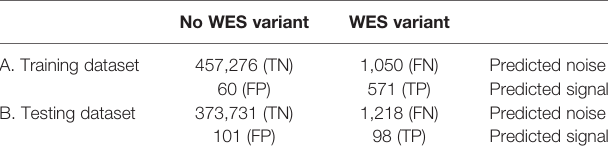
FIGURE 3 | XGBoost binary classi fi er development work fl ow. TCGA FFPE samples with matched WES and RNAseq data were reanalyzed to produce callsets in the VCF format. Thirty-two features were introduced to the model in total. RNAseq fi les along with matching WES fi les were randomly assigned to two subgroups with variants merged respectively to obtain two sets of variants for each data source. RNAseq variants from the training subgroup were labeled by cross-referencing with the WES callset. Variants matched in WES callset by genomic coordinate were labeled as “ signal ” and the rest as “ noise. ” After the model was trained to distinguish between the two classes and validated, variants in the testing subset were reaggregated per sample. Filtering out variants predicted as “ noise, ” testing per-sample callsets were used to calculate TMB estimates and compared against the respective WES-derived estimates to obtain correlation coef fi cients and ROC AUC scores. TABLE 2 | Confusion matrices for the XGBoost binary classi fi er predictions (TCGA FFPE dataset, according to WES-TMB standards calculated with matched normal WES pro fi